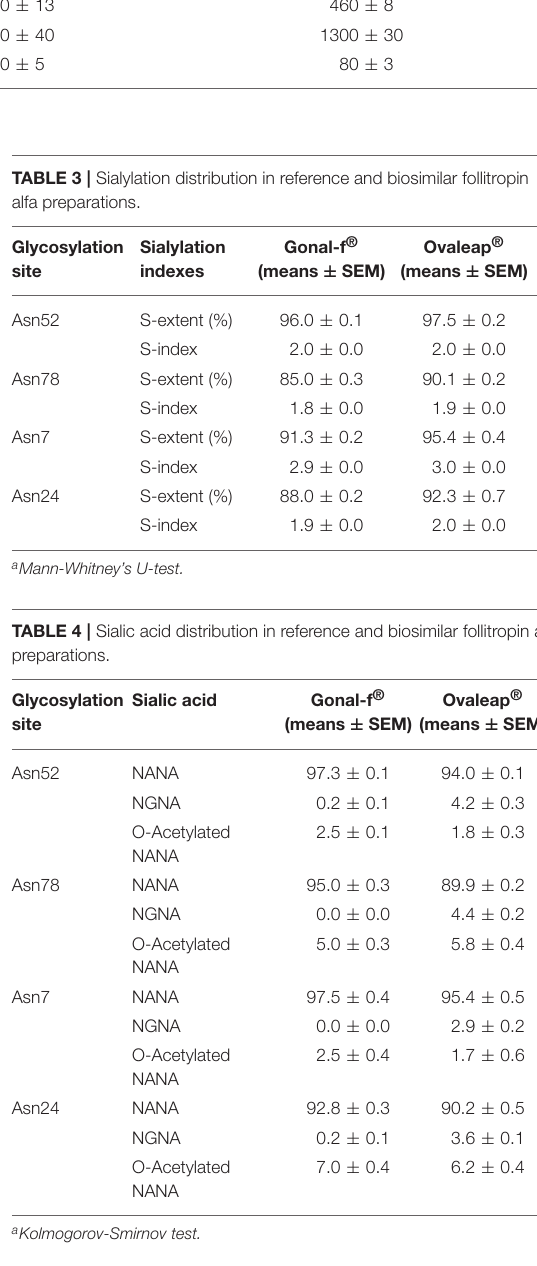
between Gonal-f R (cid:13) and biosimilars’ EC 50 required for activating cAMP ( Table 5 ; 12.9 ± 2.5–24.2 ± 6.0 ng/ml range; Kruskal- Wallis test, p ≥ 0.05; n = 4; Figure 2A ) and β -arrestin